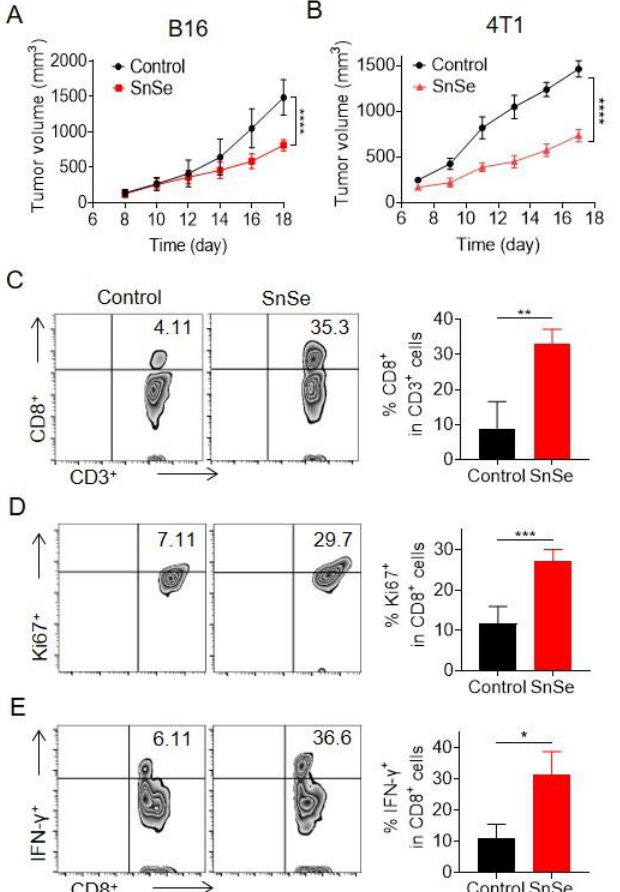
Figure 4. Antitumour therapy of SnSe NSs in multiple tumor models. ( A , B ) The tumor growth curves in B16 and 4T1 subcutaneous tumor mice treated with SnSe NSs ( n = 5). ( C – E ) Representative flow cytometry zebra plots and statistical analyses of immune cells in the B16 tumor model with SnSe NS treatments. ( C ) CD8 + T cells. ( D – E ) Quantitative analysis of Ki67 and IFN- γ within CD8 + T cells. Data are means ± SDs. Statistical significance between different groups was obtained by Student’s t -tests (two-tailed). p -value: * p < 0.05; ** p < 0.01; *** p < 0.001; **** p < 0.0001. a.u., arbitrary units.